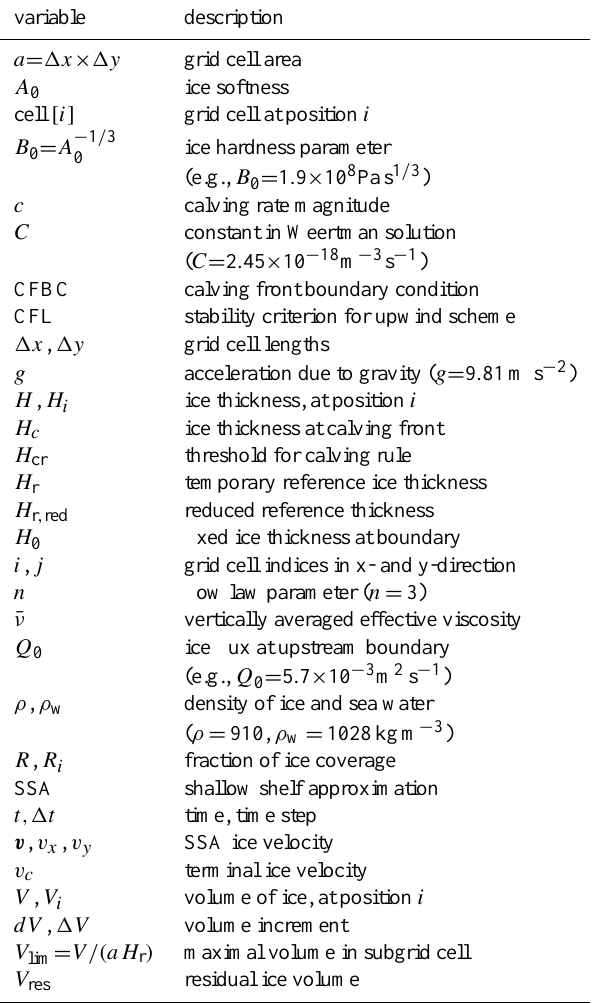
Table 1. Table of variables and